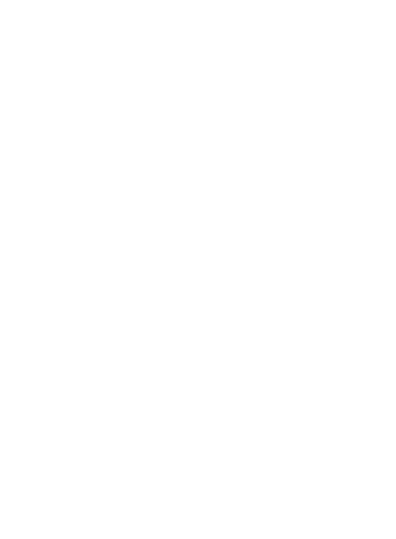
Figure 5. Modified Scherrer’s equation (the graph of lnβ against ℓn(1/cosθ)).